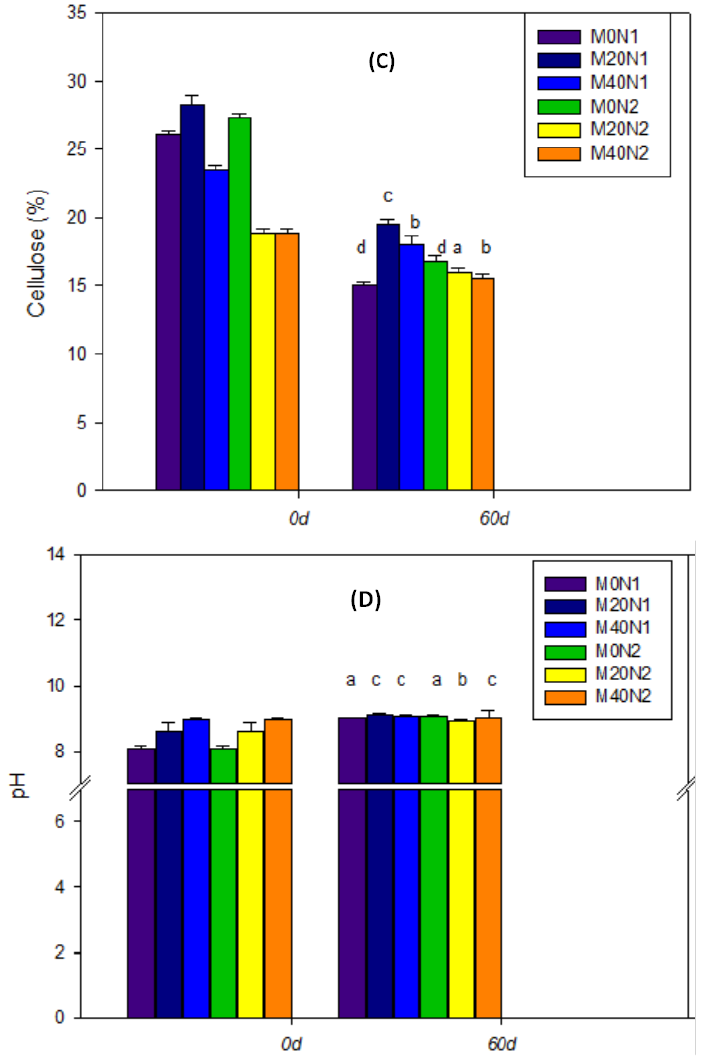
Figure 3. Changes in the physicochemical properties of the different treatments at 0 and 60 days. Comparing the difference values of orgnic matter of 60 day to 0 day ( A ), C/N ratio of 60 day to 0 day ( B ), cellulose of 60 day to 0 day ( C ), pH value of 60 day to 0 day ( D ) in different treatments; different letters in arrows are significant at p < 0.05 (Tukey’s test).